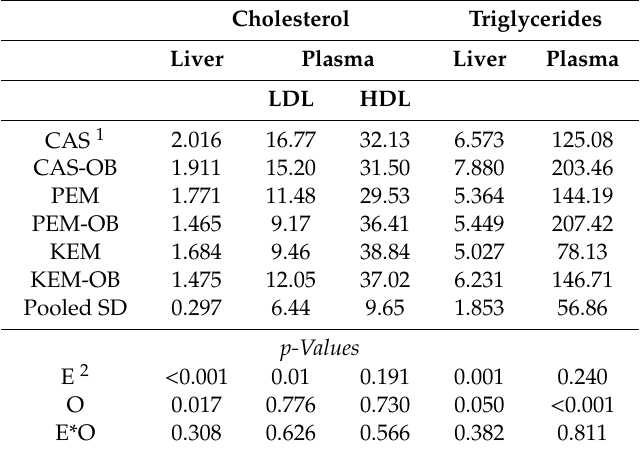
Table 6. Cholesterol and triglyceride concentrations in liver (mg / g fresh weight) and plasma (mg / dL) of rats fed casein or casein plus extruded mix diets either obesogenic or not. Cholesterol Triglycerides Liver Plasma Liver Plasma LDL HDL CAS 1 2.016